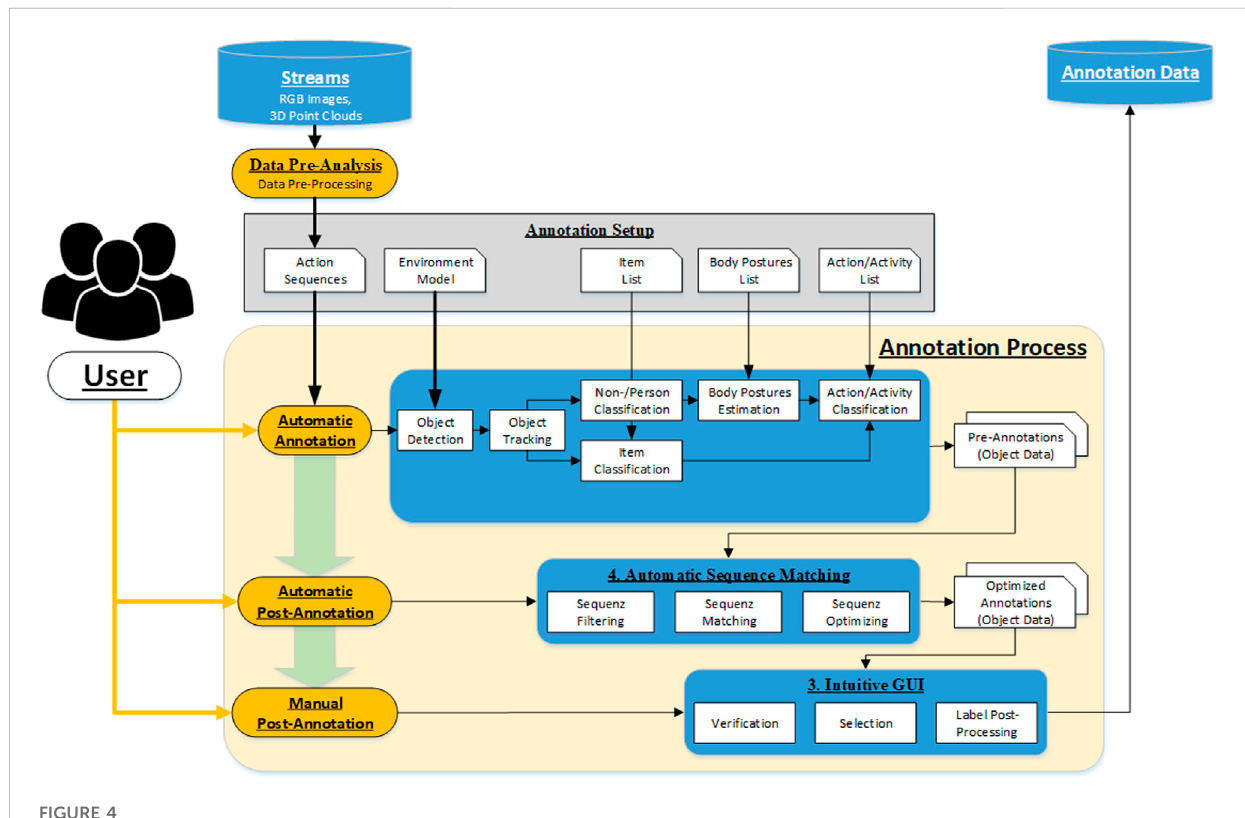
FIGURE 4 Schematic work fl ow of the annotation